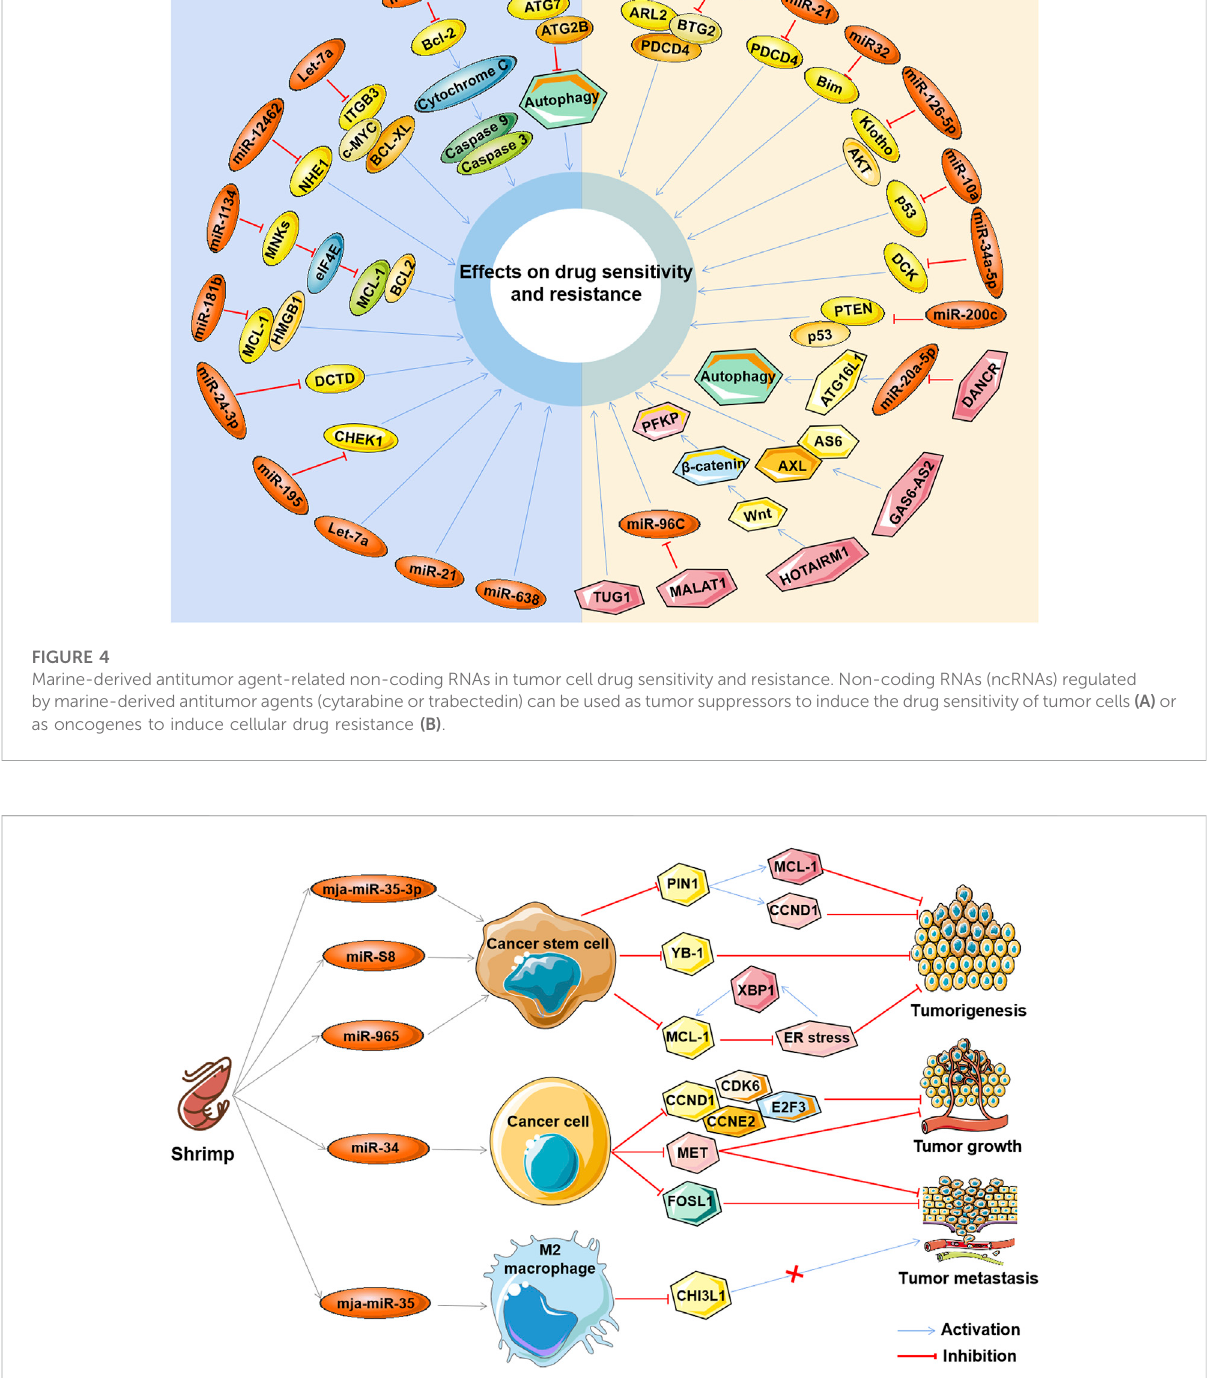
FIGURE 5 The antitumor effects of marine shrimp-derived microRNAs. microRNAs (miRNAs) derived from marine shrimp ( Marsupenaeus japonicus ) exhibit antitumor ability by regulating cross-species gene expression to inhibit human tumorigenesis, tumor growth, and tumor